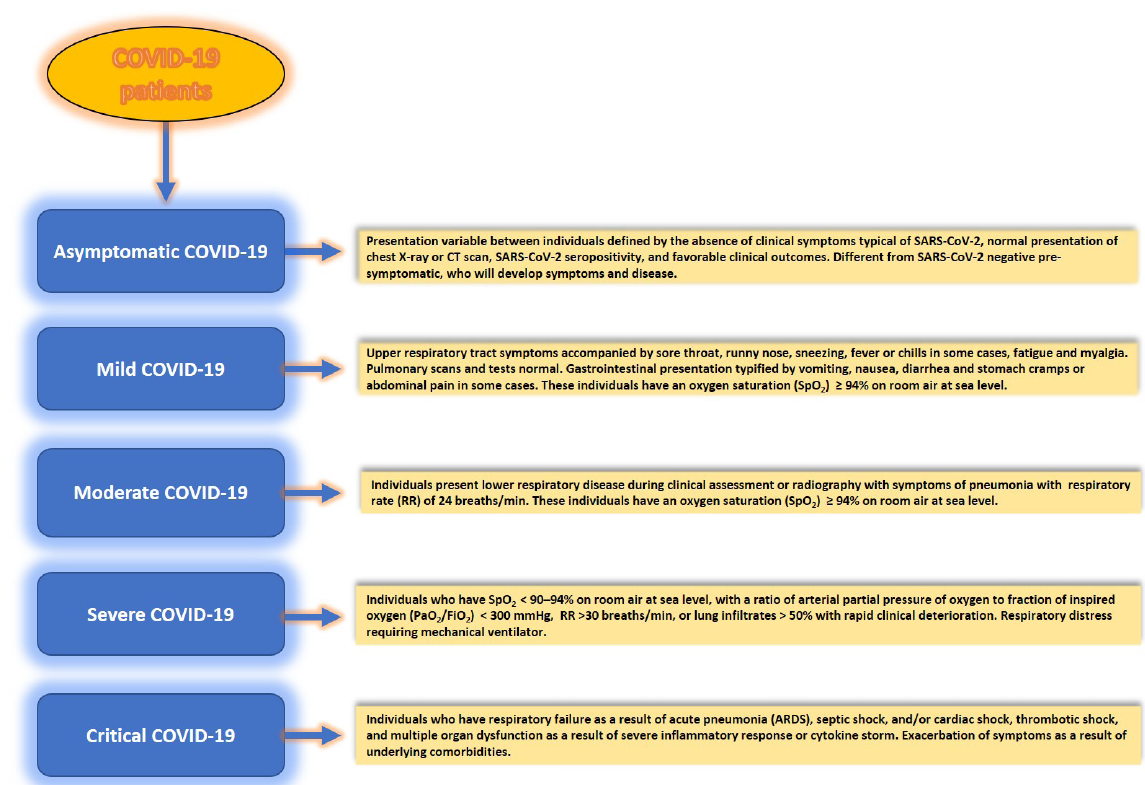
Figure 1. Patients with SARS-CoV-2 infection experience a range of clinical manifestations which define disease severity. Clinical spectrum and disease categories (asymptomatic, mild, moderate, severe, and critical) in SARS-CoV-2 infection of the human host. Considerable inter-host variability in symptomatology exists between infected individuals. Although adults with SARS-CoV-2 infection can be stratified into these disease categories, the criteria for each category could also overlap between different categories. CT: computed